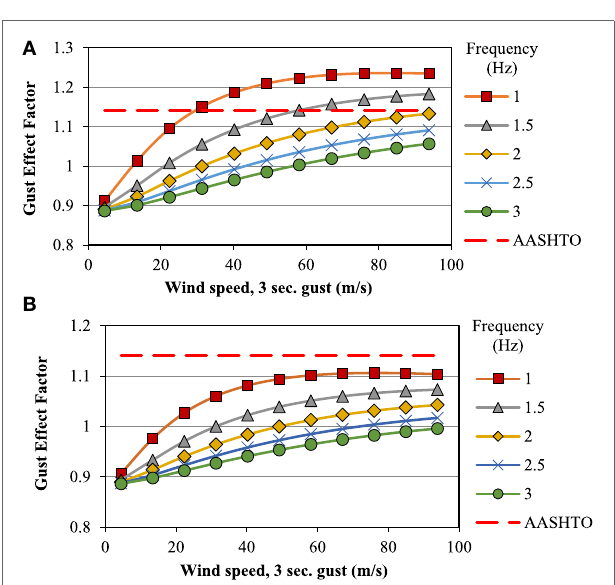
FIGURE 9 | Estimated gust effect factor for large sign: (A) heavier weight; (B) lighter weight.